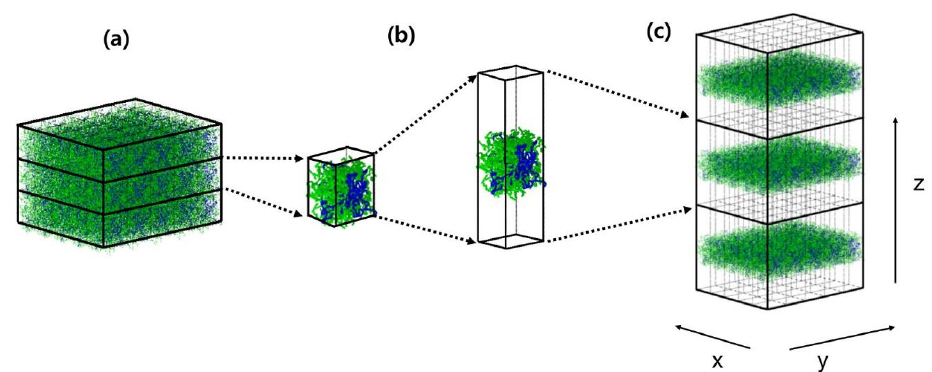
Figure 1. Simulation scheme to prepare a thin film: Equilibrium bulk phase with periodic boundary conditions ( a ), elongation along one ( z ) direction ( b ), and thin films with periodic boundary conditions ( c ). This snapshot was captured during simulation of the mixture of C 150 H 302 (green) and C 13 H 28 (blue).